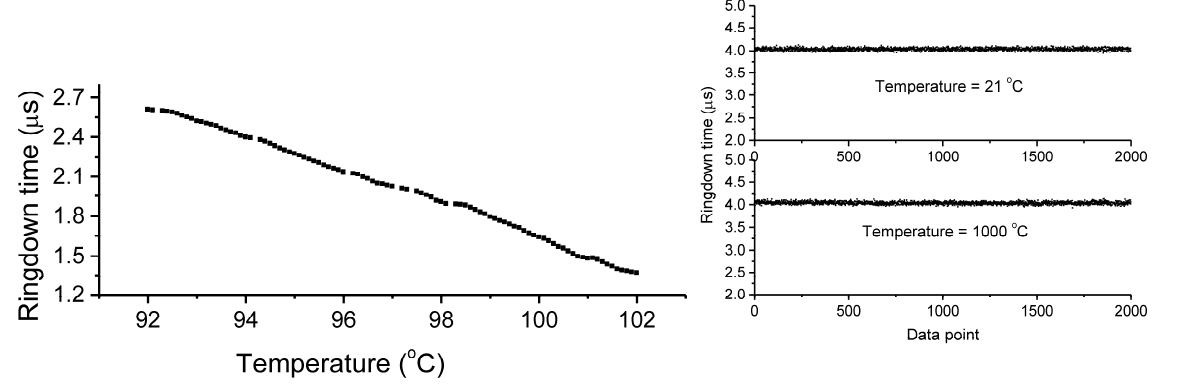
Figure 5. FLRD temperature sensors. (Left) FBG as the sensing element showing high precision; (Right) showing high baseline stability at low and high temperatures (Reproduction permission from Institute of Physics